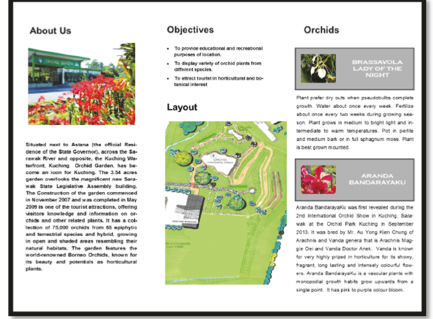
Figure 7: Information about orchid (back